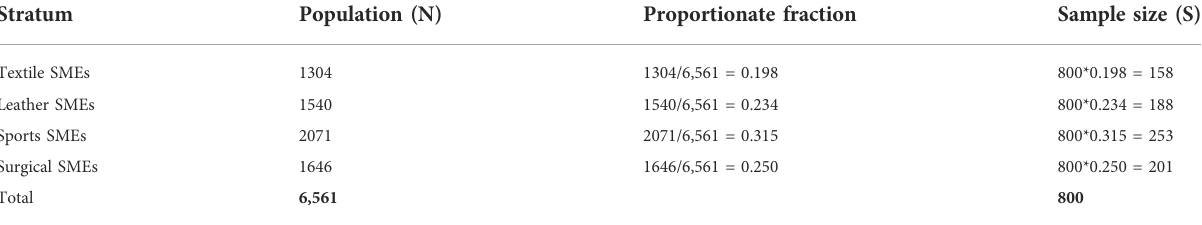
TABLE 1 Sample size calculation based on strati fi ed proportionate